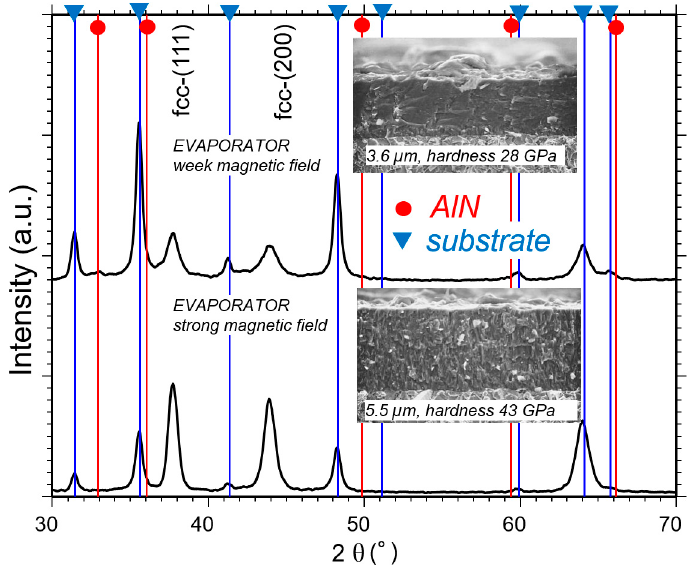
Figure 18. Phase formation of coatings deposited with pm cathodes Al 70 Cr 30 for two evaporators with different magnetic field set-ups [93].